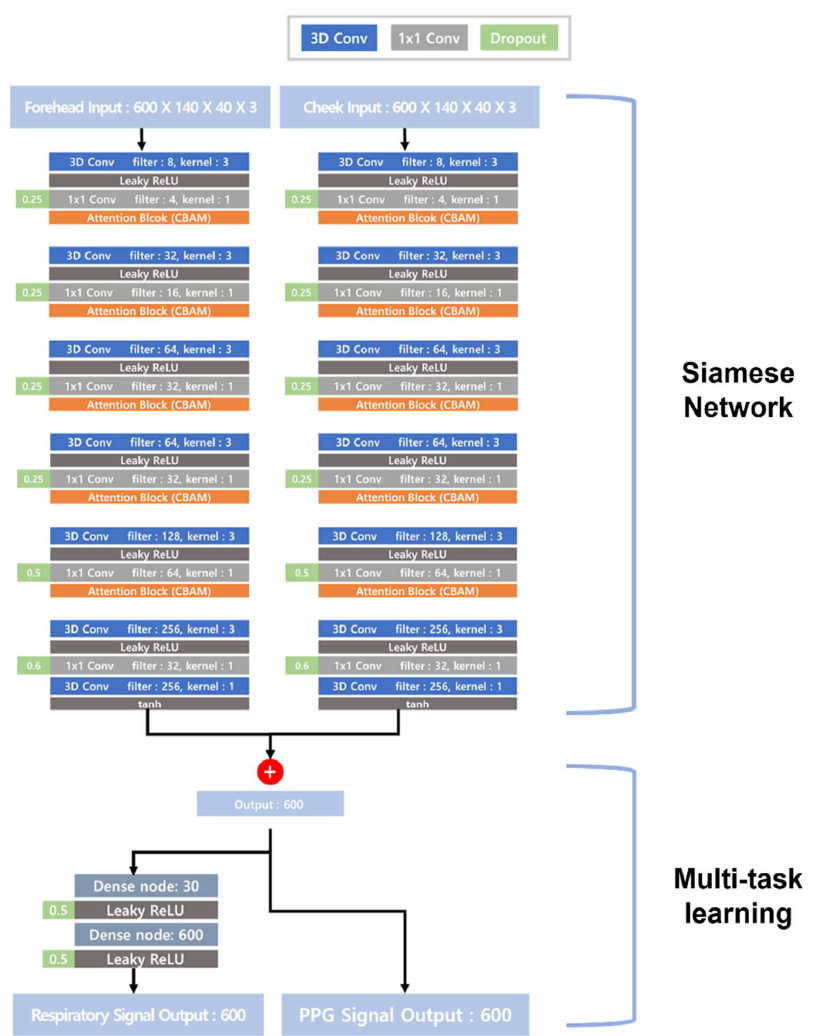
Figure 2. Structures of multitask Siamese network MTS. The input data are 140(w) × 40(h) images of the forehead and cheek as three RGB channels with 600 frames. The dimension of the input data is ‘frame × width × height × channel’. The output shows the PPG and the respiratory signals as 600 frames.